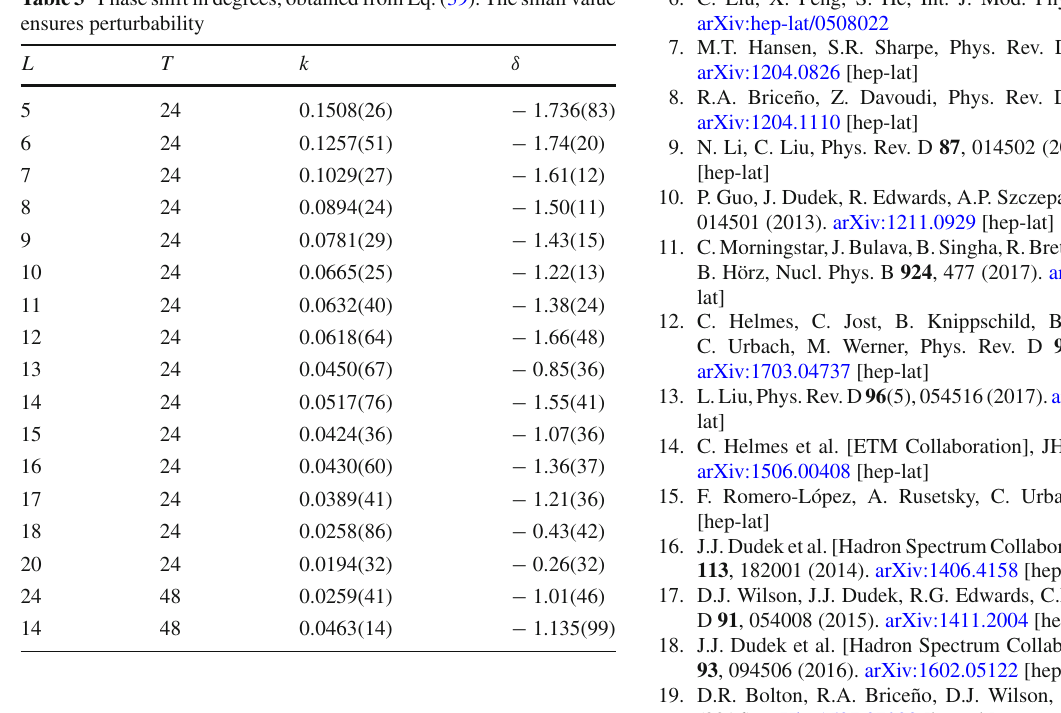
Table 4 Exemplary fit results for (cid:7) E 2 [ L , L ] a χ 2 / d . o . f . i f